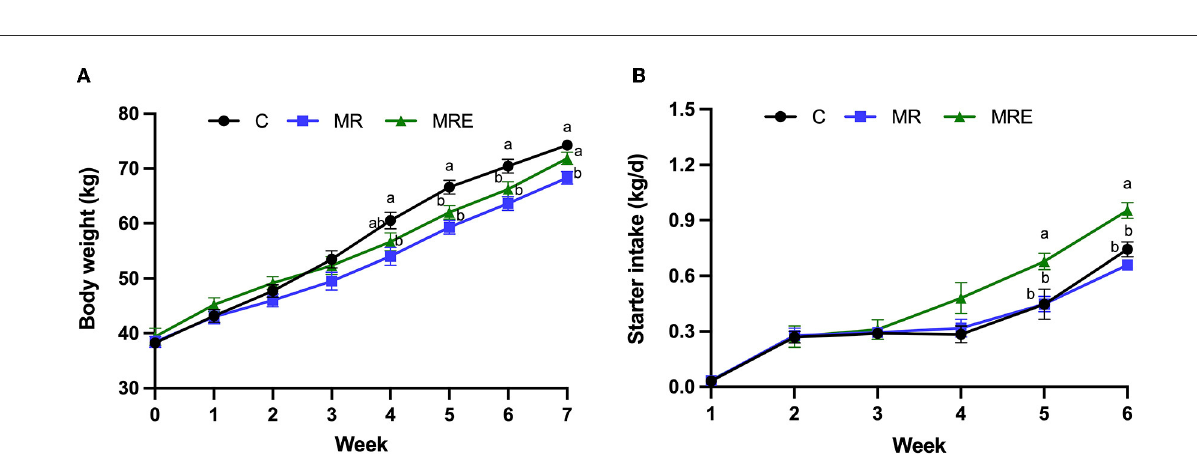
TABLE 3 Effects of milk, milk replacer and milk replacer plus ethoxyquin on growth of Holstein calves ( N = 11,9, and 11 in C, MR, and MRE, respectively). Treatments 1 SEM